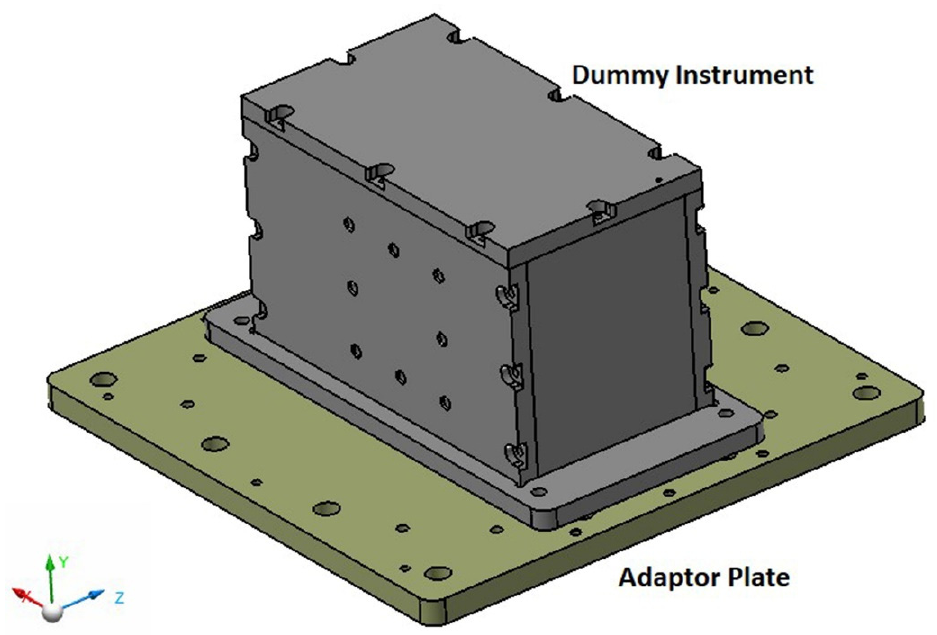
Figure 10. CAD representation of dummy instrument.